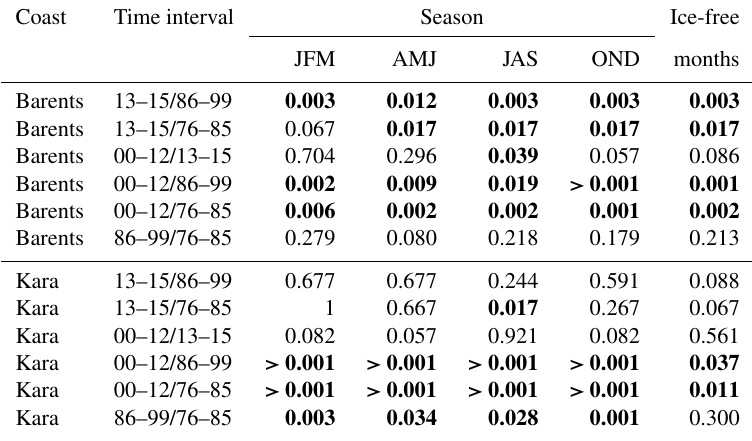
Table 4. P values for Wilcoxon tests for significant differences in mean seasonal sea ice concentrations and the number of ice-free months, for the periods 1976–1985, 1986–1999, and 2000–2013. Following convention, p values of < 0.05 are considered significant and are highlighted in